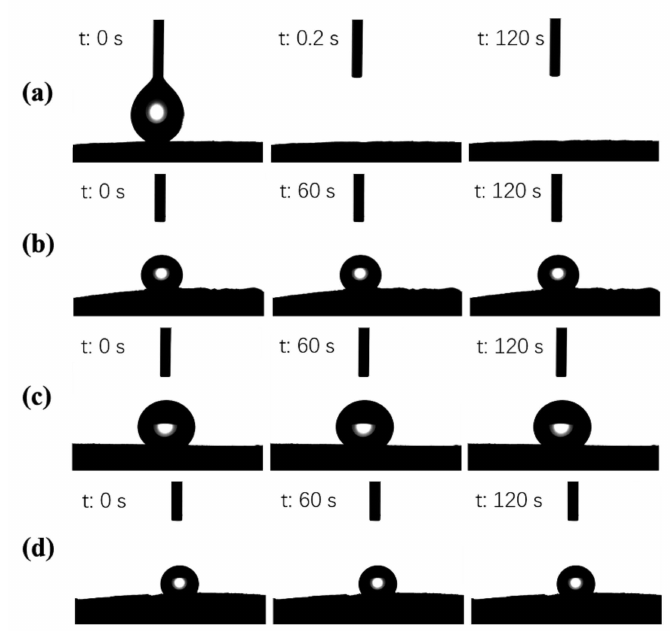
Figure 9. Water contact angle of ( a ) CPGA, ( b ) d-MCPGA, ( c ) r-MCPGA and ( d )